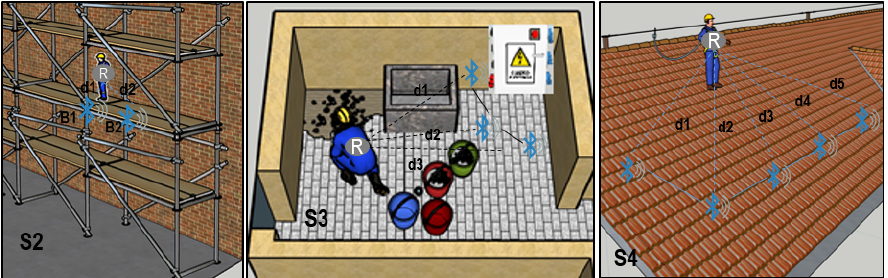
Figure 10. Different usage scenarios of the virtual fence on scaffolding task (S2), with electric risk (S3) and roofing (S4).